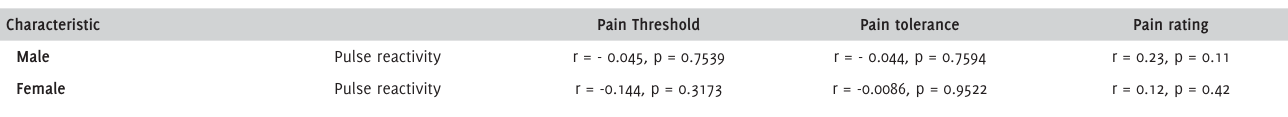
*p<0.05-statistically